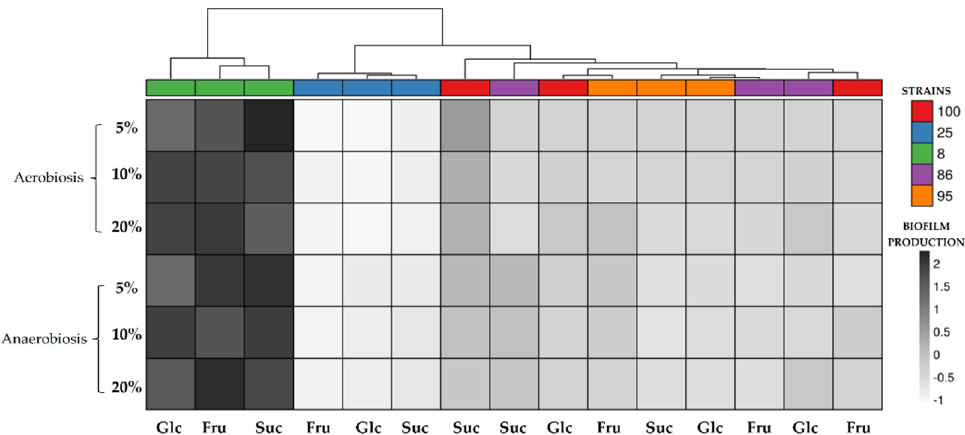
Figure 3. Biofilm production of L. plantarum LP8, LP25, LP86, LP95 and LP100 strains in aerobiotic and anaerobiotic conditions and with different sugar concentrations (5%, 10% and 20% (Glc: glucose; Fru: fructose; Suc: sucrose)). This figure was generated using ClustVis web tool [65] https://biit.cs.ut.ee/clustvis/ (accessed on 4 December